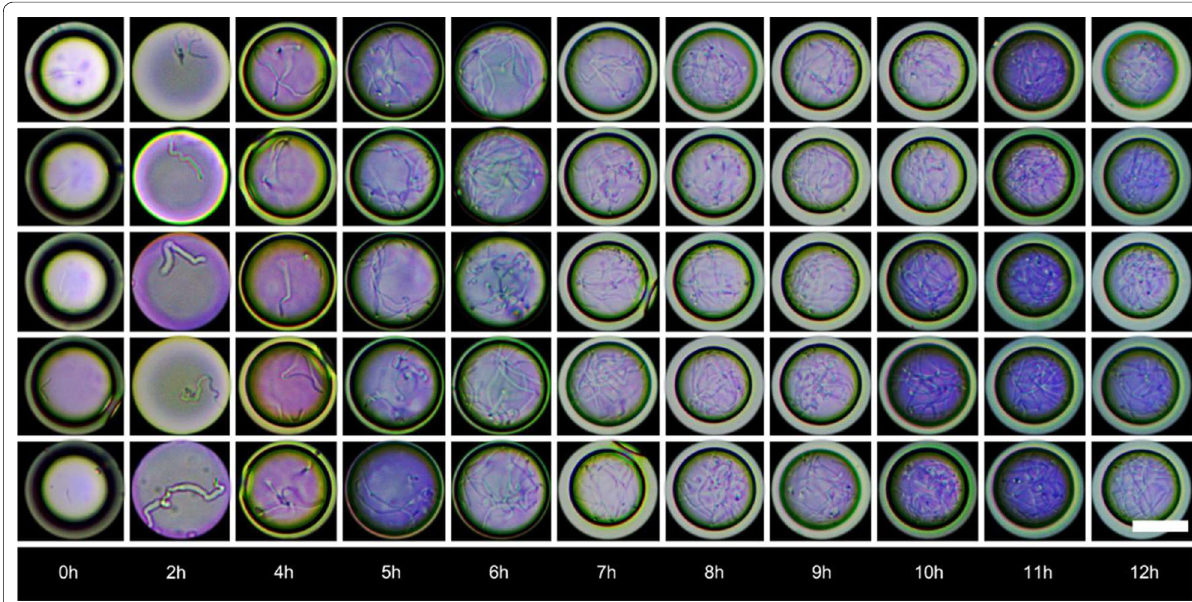
Fig. 3 The growth of B. coagulans cells in microdroplets at 50 °C for 12 h. Bright-field images show the increase in length and the division of B. coagulans . Scale bar: 20